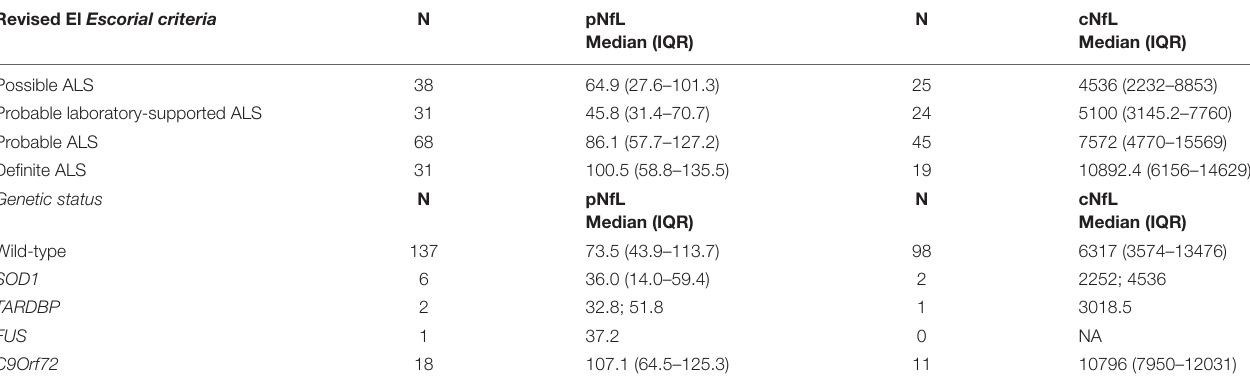
TABLE 3 | pNfL and cNfL levels according to the accuracy level of the categories of the Revised El Escorial diagnostic criteria and to genetic status (i.e., wild type vs. ALS gene mutations). Revised El Escorial